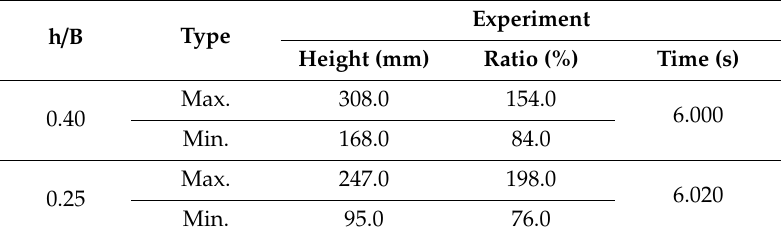
Figure 3. Shaking table test result for the scaled model. Table 1. Results summary of the scaled model shaking table test.